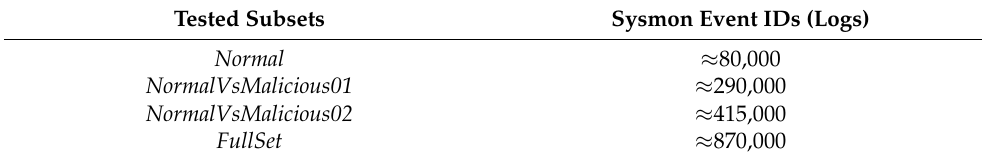
Table 4. Subsets examined with PeX , including the total number of .evtx logs per subset.